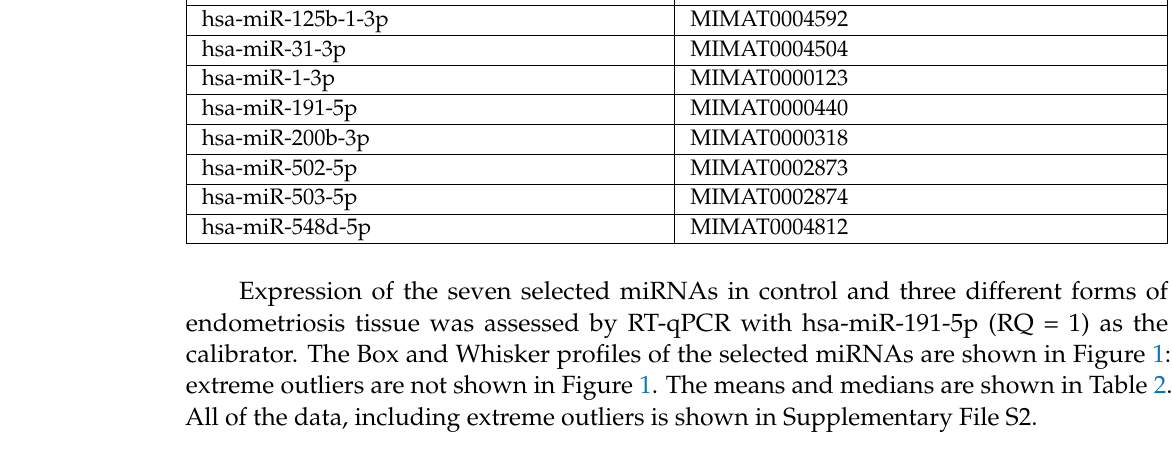
Table 2. Relative quantification of the miRNAs in the tissue samples from the different forms of endometriosis and the control group. miR-191-5p (RQ = 1) served as the